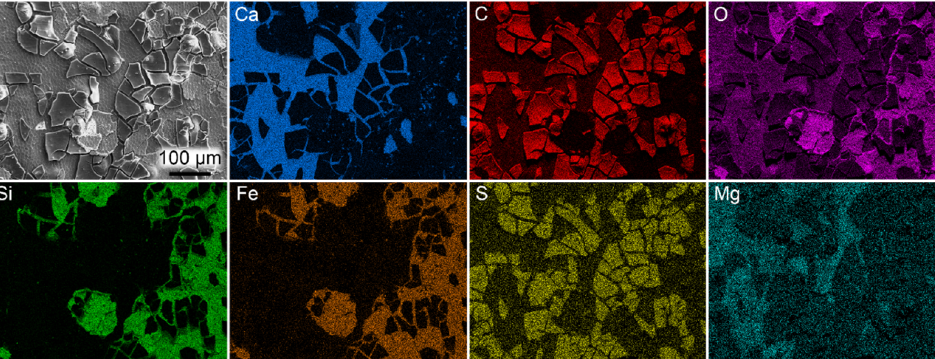
Figure 2. SEM-EDX elemental maps obtained from the fossil beetle elytra (FUM-N-17627). C, carbon ( red ); Ca, calcium ( blue ); Fe, iron ( orange ); Mg, magnesium ( cyan ); O, oxygen ( purple ); S, sulfur ( yellow ); Si, silicon ( green ).